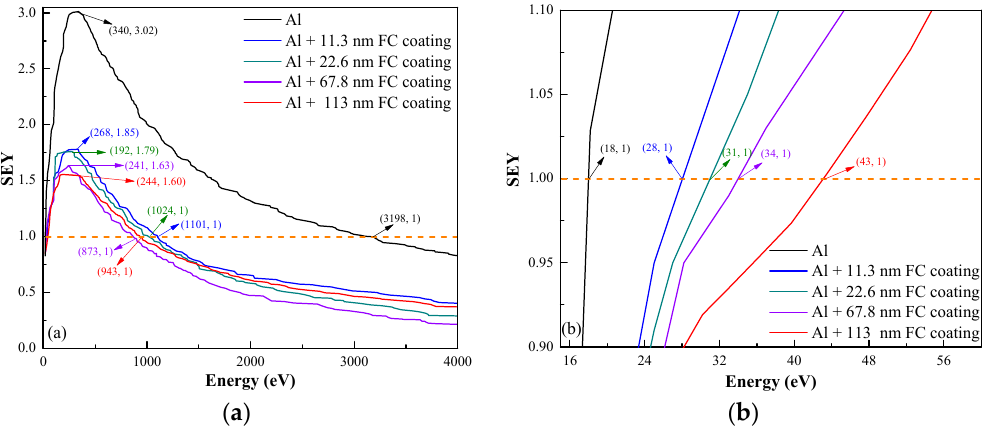
Figure 4. Energy dependence of secondary electron yield (SEY) of samples. ( b ) is zoomed in from ( a ).